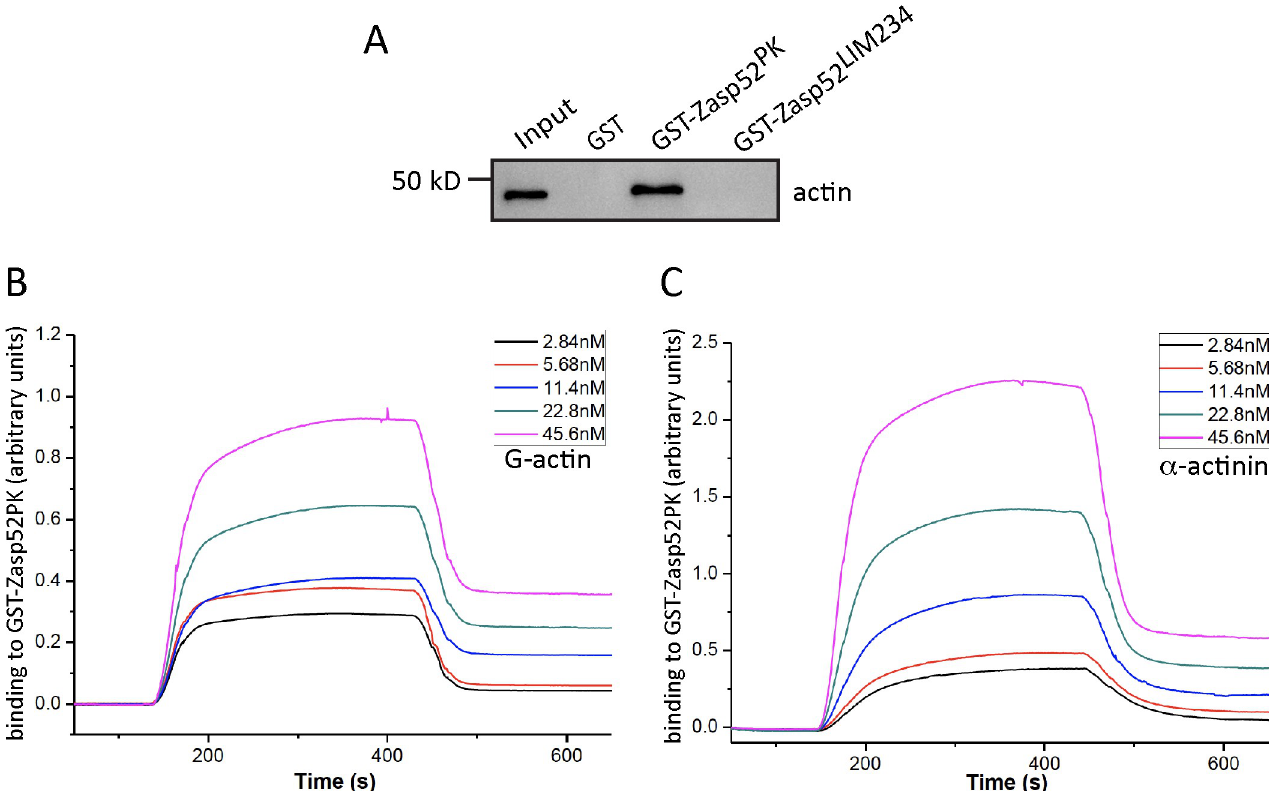
Fig 3. Zasp52 binds actin with micromolar affinity. ( A ) GST pull-down assay. Zasp52-PK, the N-terminal half of Zasp52, binds actin, while Zasp52-LIM234, the C-terminal half of Zasp52, and GST alone do not bind. Binding results were observed in at least three independent experiments. ( B , C ) Surface plasmon resonance imaging of the real-time binding to GST-Zasp52-PK tethered to the biosensor chip. ( B ) Binding of indicated concentrations of G-actin flown into the chamber at 100 s and replaced with buffer at 500 s. ( C ) Binding of indicated concentrations of α -actinin flown into the chamber at 100 s and replaced with buffer at 500 s. Binding is measured in real time in arbitrary